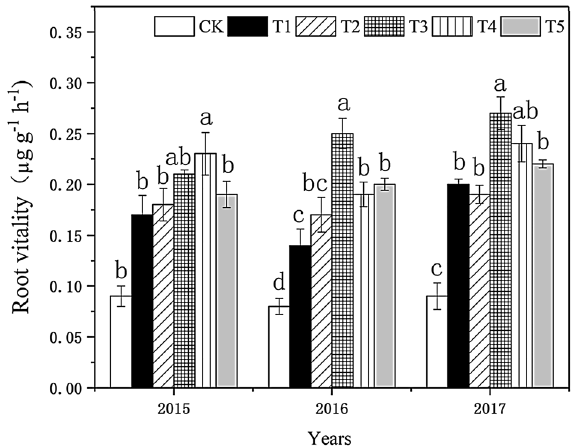
Figure 1. Effect of biochar treatment on the root vigor of tobacco. Note: Six biochar application levels: CK = 0 kg/ha, T1 = 600 kg/ha, T2 = 1200 kg/ha, T3 = 1800 kg/ha, T4 = 2400 kg/ha, T5 = 3000 kg/ha; The error bars are standard deviation; different letters on the error lines indicate significant differences between different treatments (α =